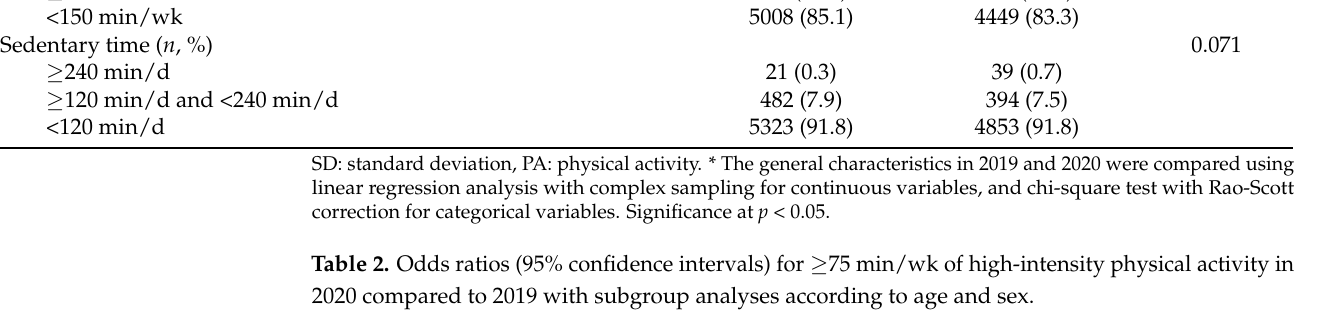
Table 2. Odds ratios (95% confidence intervals) for ≥ 75 min/wk of high-intensity physical activity in